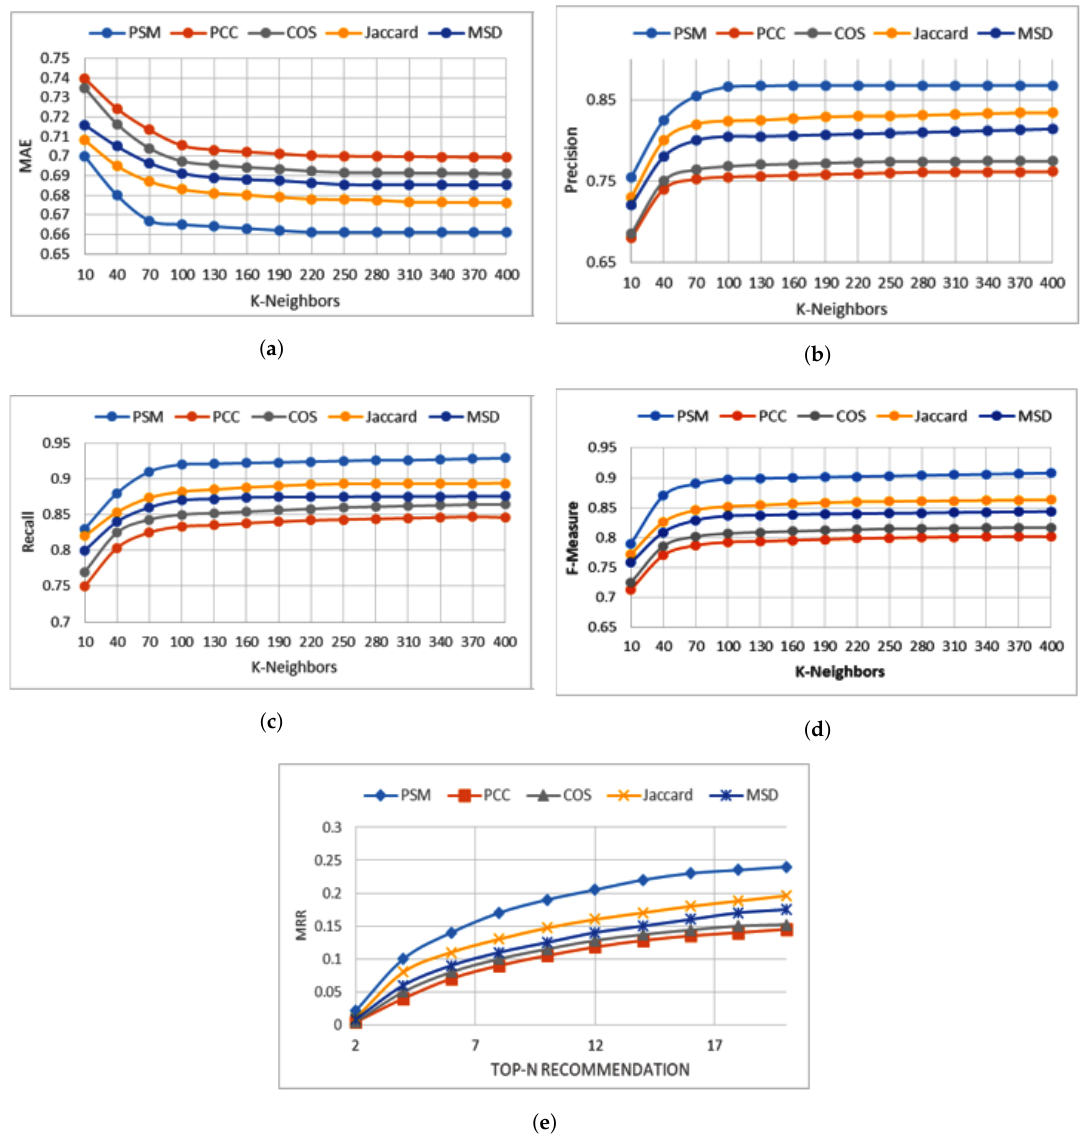
Figure 3. Comparison of proposed and benchmark methods in reference to ( a ) MAE; ( b ) precision; ( c ) recall; ( d ) f-measure and ( e ) MRR for Movielens dataset.